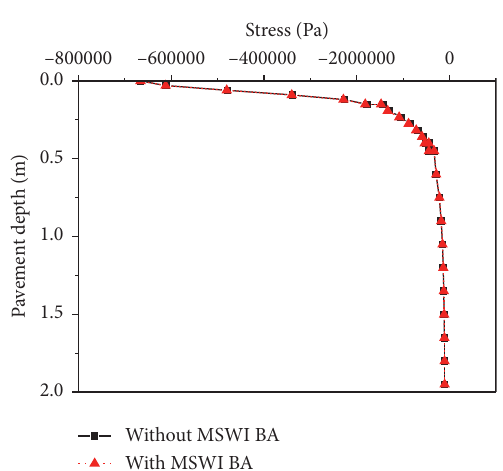
Figure 12: Compressive stress along the pavement